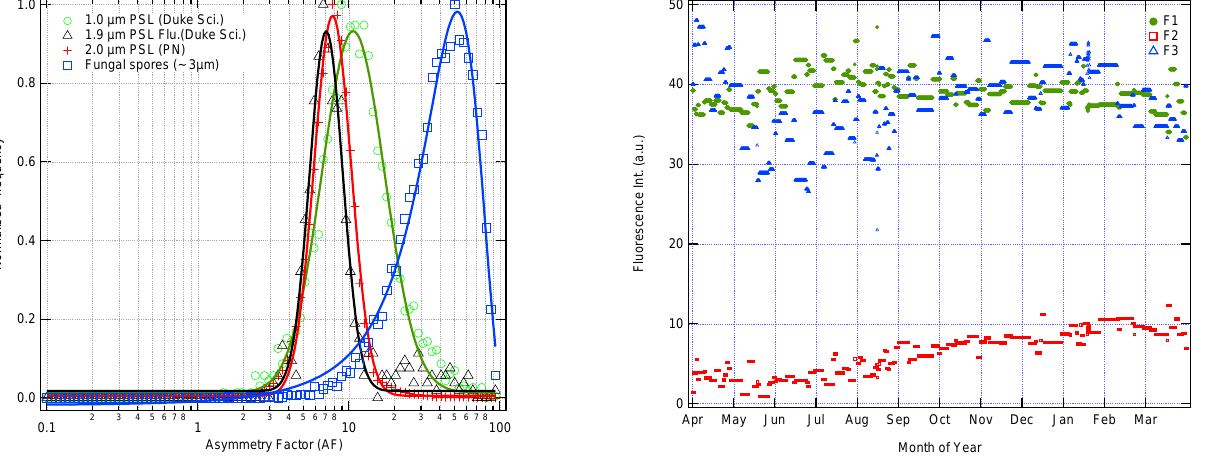
Fig. 1. Asymmetry factor (AF) plot for PSL particles and penicil- lium notatum type of fungal spores. The fungal spores were sup- plied from the Swedish company Allergon (Allergon AB, Sweden) and included their mycelia.